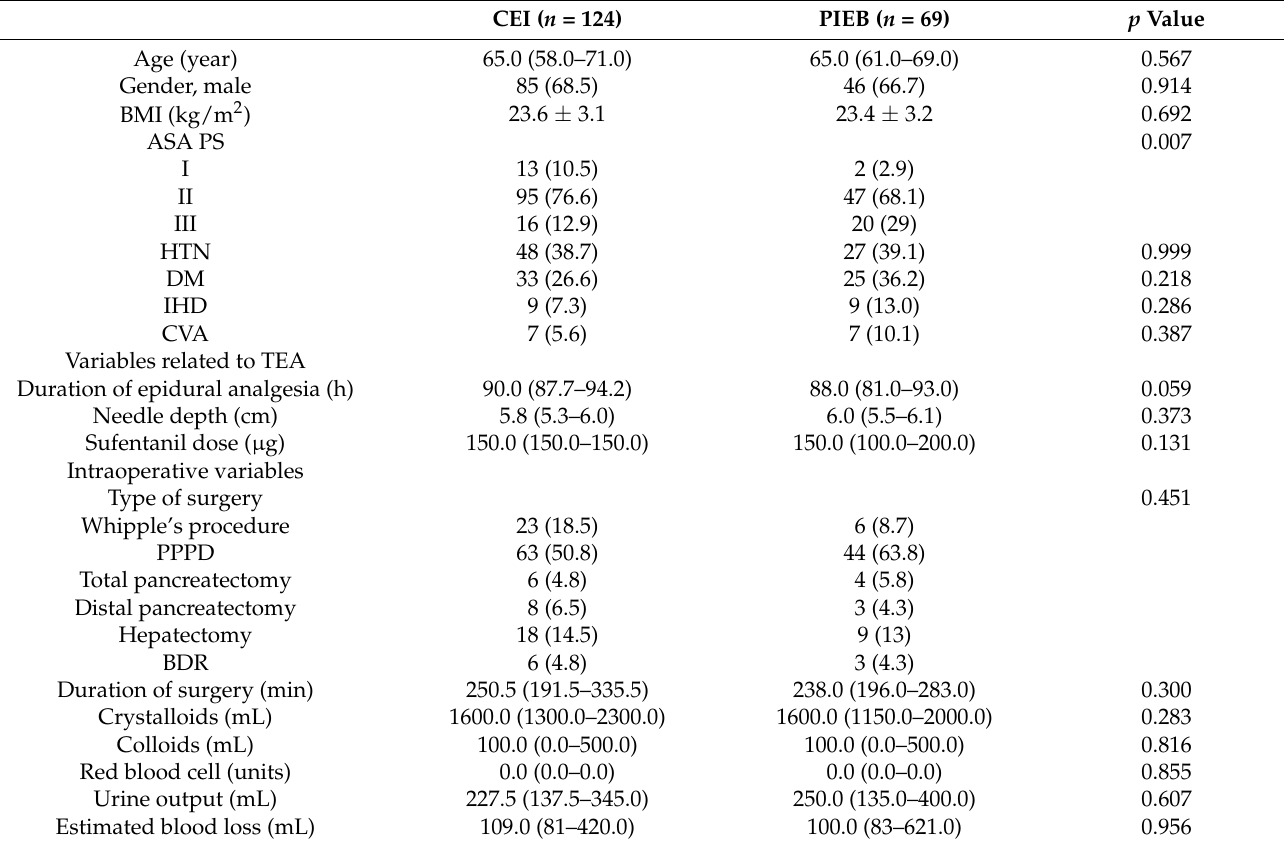
Table 1. Patient characteristics and perioperative variables.